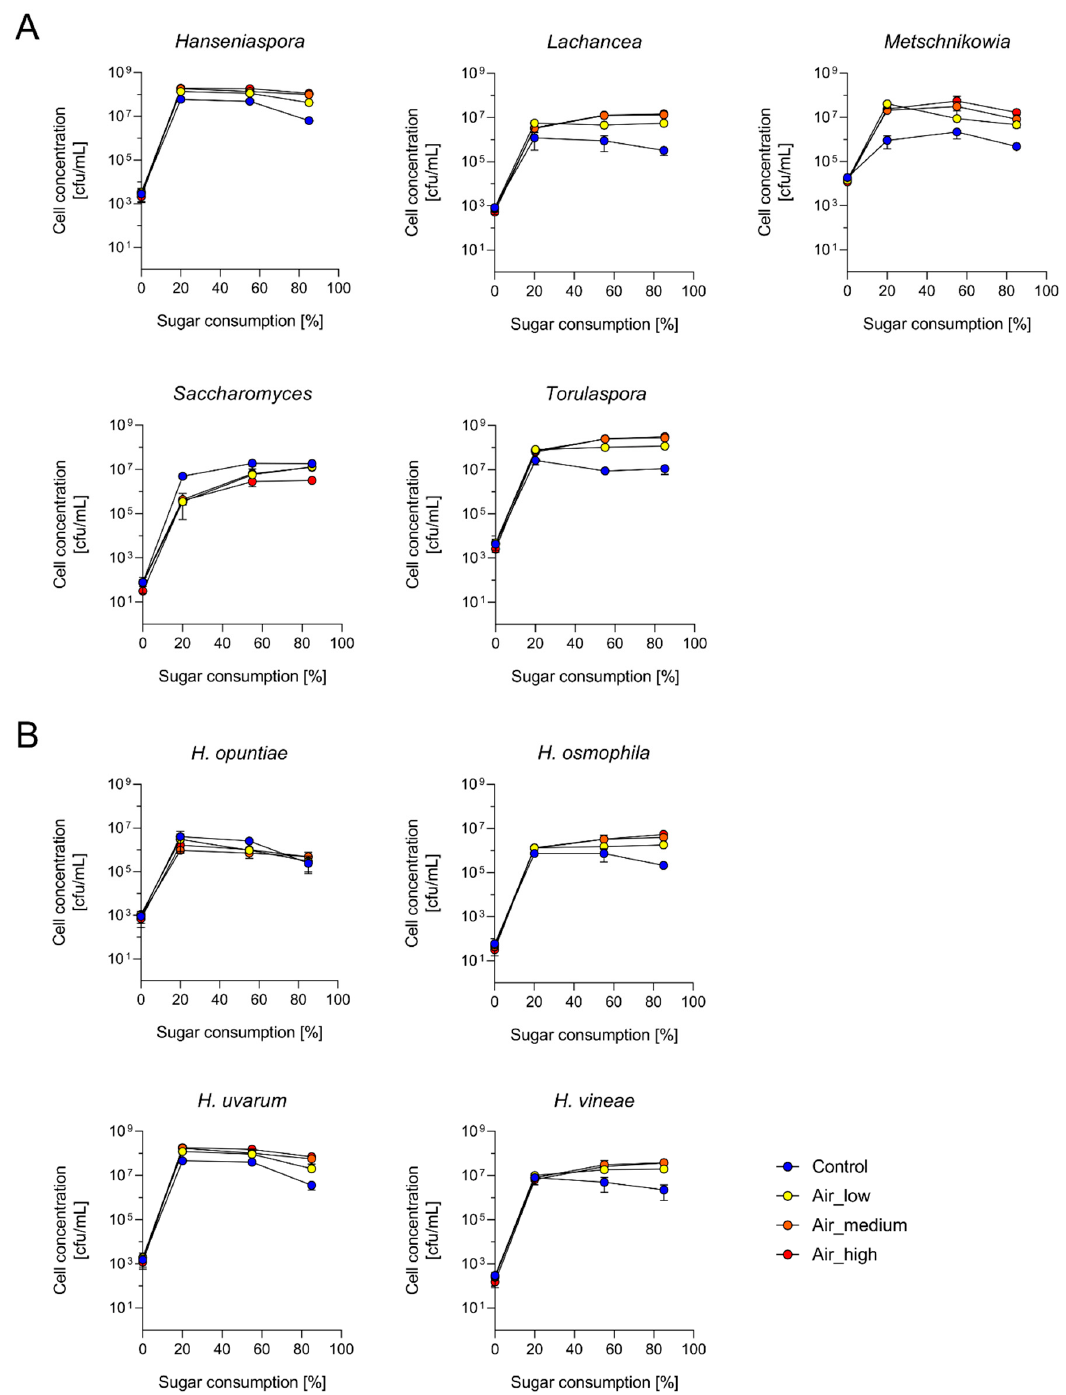
Figure 5. Estimated yeast counts for the main yeast genera ( A ) and for Hanseniaspora species ( B ) found in ferments from the 2020 vintage. All symbols show means of three treatments with error bars showing SD.